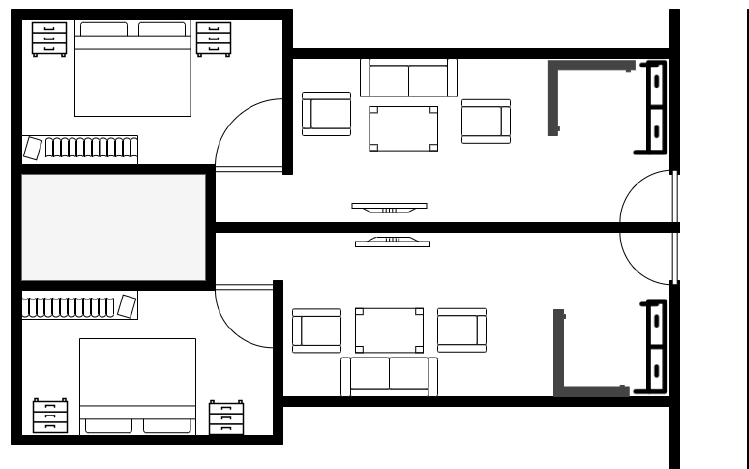
Figure 8. Experimental area floor map.